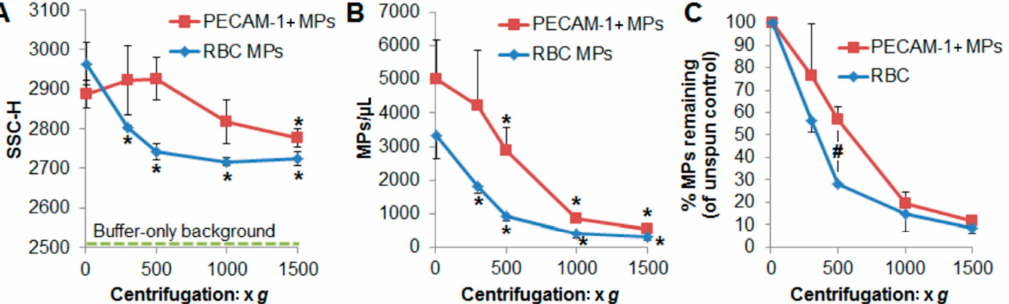
Figure 5. RBC MPs/RMVs sediment at lower speeds than PECAM-1 + MPs. As proof-of-principle, RBCs and platelet-rich plasma were subjected to extrusion through 0.45 µ m pore size membranes to generate similarly sized MVs and, subsequently, centrifuged at different speeds before flow cytometry enumeration. ( A ) The relative size of the resulting MV populations (SSC-H) significantly decreased at all centrifugation speeds tested for RMVs, whereas there was no significant difference in the size of PECAM-1 + MVs until subjected to 1500 × g . The green dotted line indicates the noise threshold of buffer-only liquid evaluated on the flow cytometer. ( B ) There was a significant drop in the number of RBC-MVs with any centrifugation speed; however, the decrease in PECAM-1 + MVs was not significant until 500 × g or greater. ( C ) At 500 × g , there were significantly fewer RMVs than PECAM-1 + MVs remaining relative to the initial unspun concentration. * Two-tailed t -test, p < 0.05 compared to unspun; # p = 0.010 comparing the percent remaining at 500 × g ; results are technical triplicates from a single